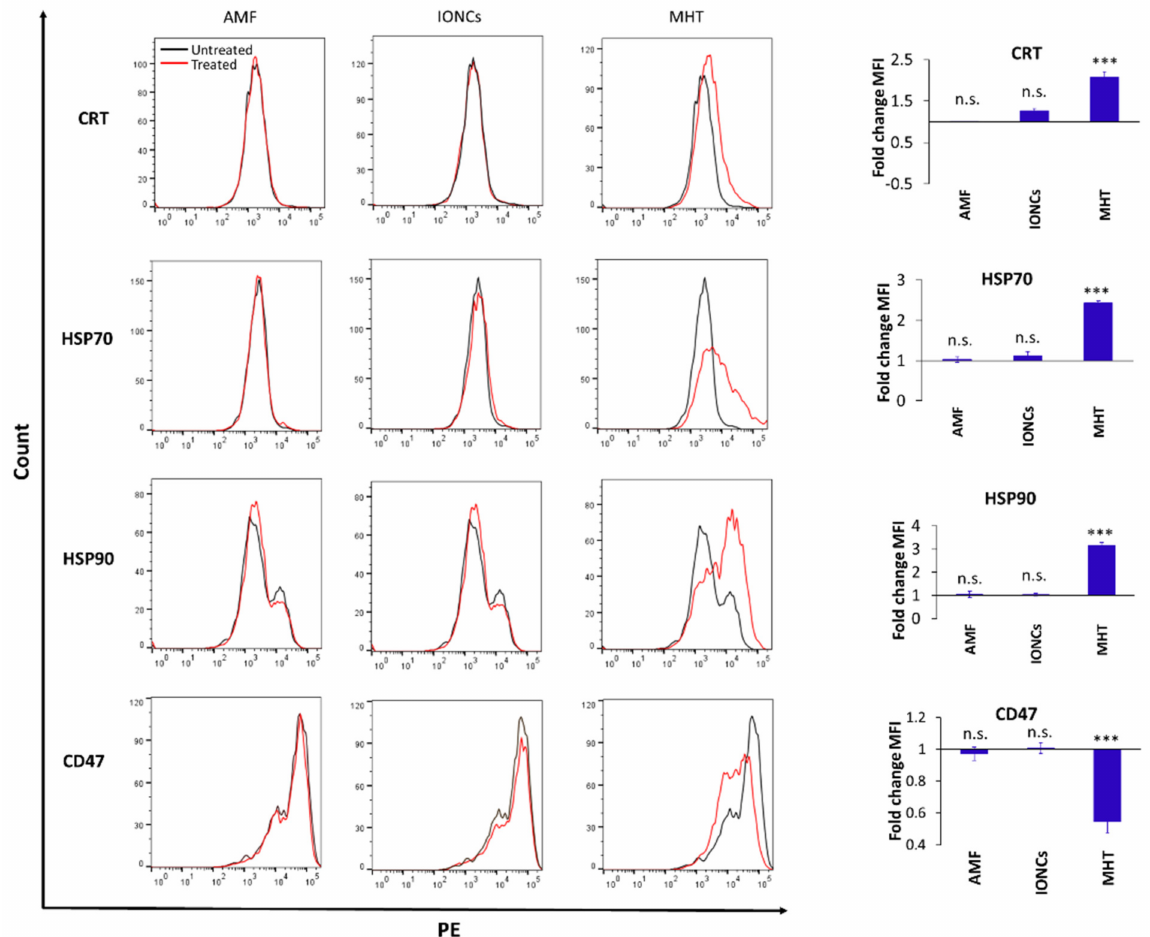
Figure 4. Flow cytometric evaluation of changes in surface expression of ICD-associated markers at 24 h post-treatment: CRT, HSP70, HSP90 and CD47 on U87 cells exposed to different treatments including AMF only (AMF), IONCs only (IONCs) and IONCs + AMF (MHT) over untreated cells. Data are presented as representative histograms and average fold change (mean ± SEM) of the mean fluorescence intensity (MFI) of three independent experiments ( n = 3). Statistical analysis was conducted via two − tailed unpaired student’s t test (*** p < 0.001; n.s. = not